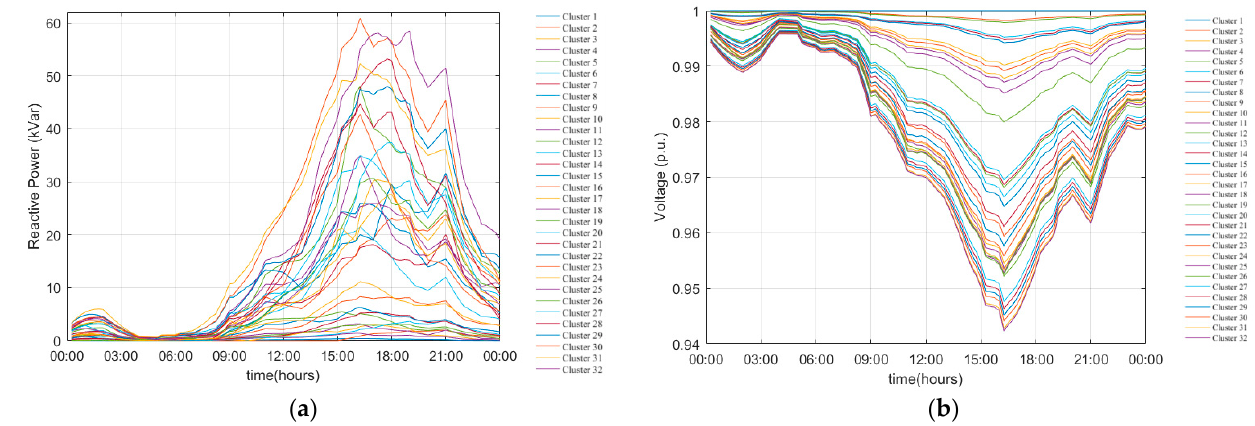
Figure 18. ( a ) Reactive power of PEVs clusters. ( b ) Distribution network node voltages.